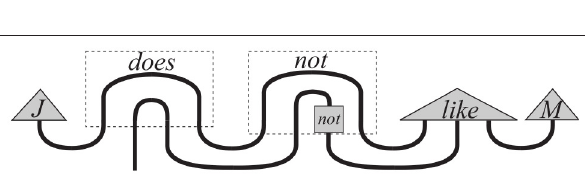
FIGURE 3 | Diagram of information flow in the negative transitive sentence, cited from Preller and Sadrzadeh [16].